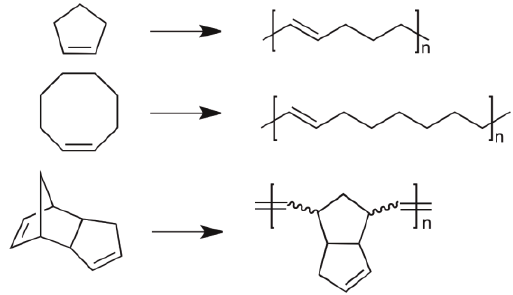
Figure 54. The structures of Norsorex ® , Vestenamer ® and Polycyclopentadiene.